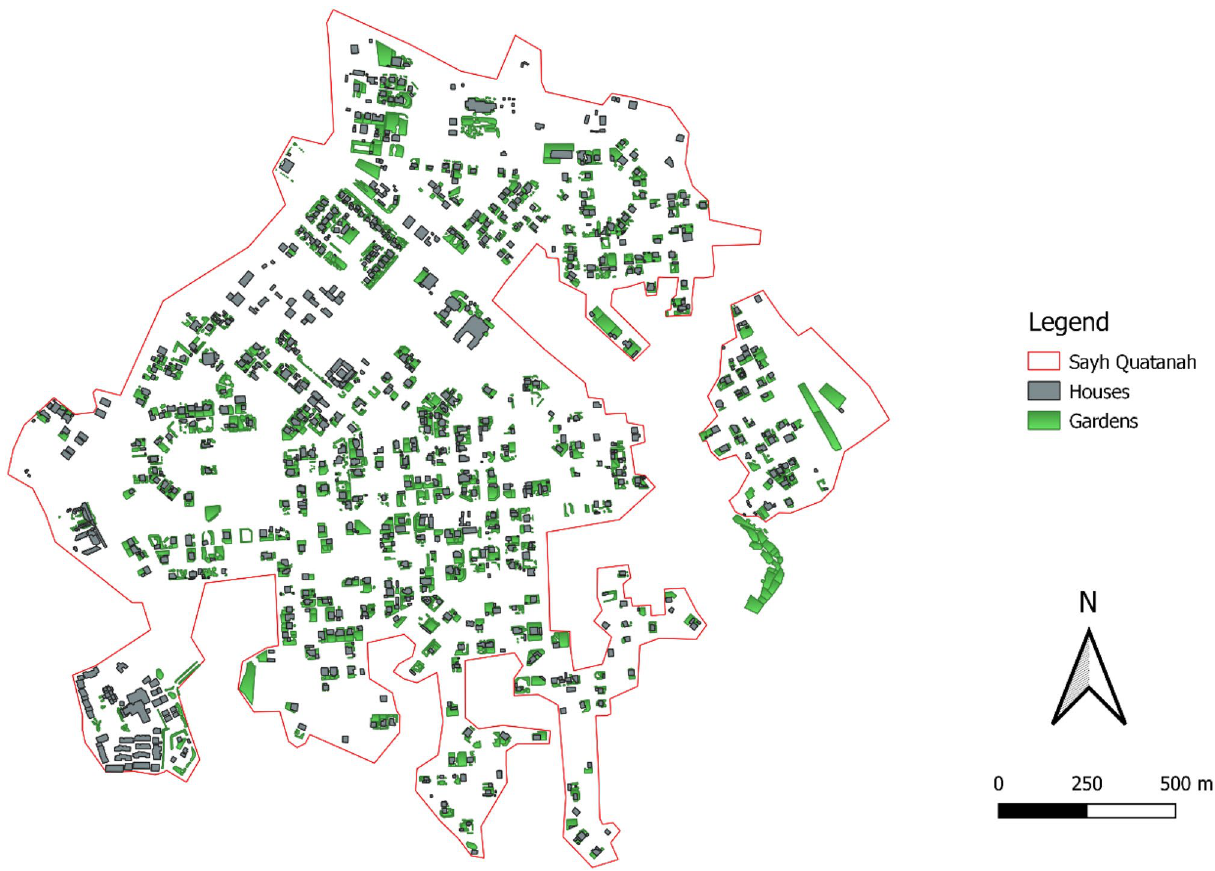
Figure 4. Map of Sayh Qatanah (2000 m a.s.l., Al Jabal Al Akhdar, northern Oman) with all buildings and irrigated areas (gardens) in April